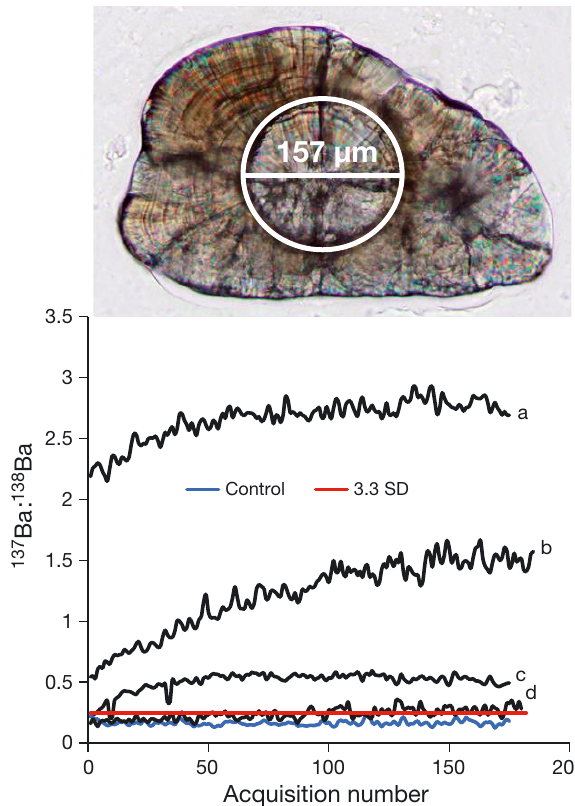
Fig. 1. Comparison of the change in 137 Ba: 138 Ba between the otolith edge (acquisition no. = 0) and core (acquisition no. 150−200) in marked yolk sac larval Atlantic salmon Salmo salar . Each black line represents an otolith marked with a different concentration of 137 Ba: a = 2, b = 0.2, c = 0.02 and d = 0.002 µg l −1 . The blue line represents a control fish, and the red line represents the mark detection limit, calculated as 3.3 standard deviations above the mean ratio measured in all control fish. A successful mark was classified as 3 consec- utive acquisitions above the detection limit. Photo indicates the diameter of the laser spot size (157 µm) used when ablat- ing from the otolith edge (surface) to the